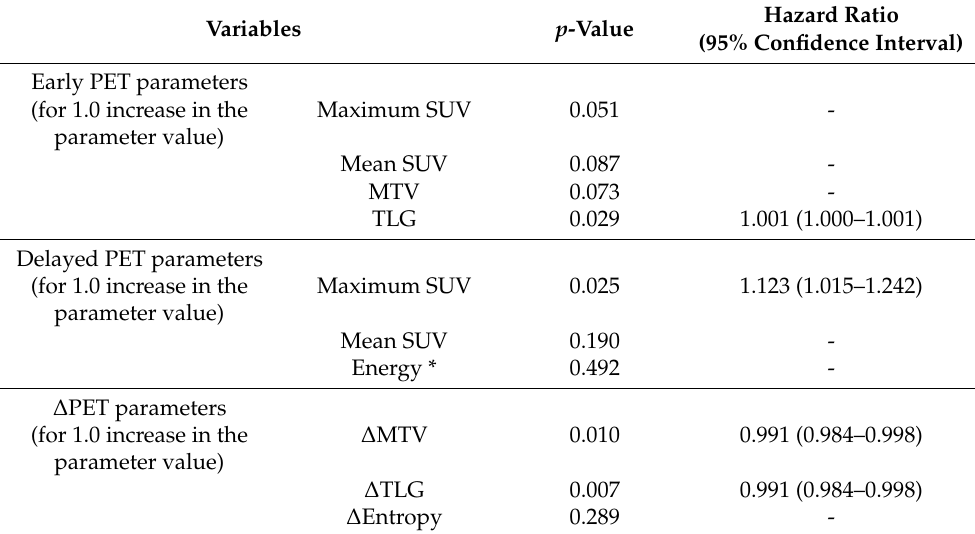
Table 5. Multivariate analysis of dual-time-point PET parameters for predicting PFS in CRT group (n = 69) after adjustment for age, sex, and TNM